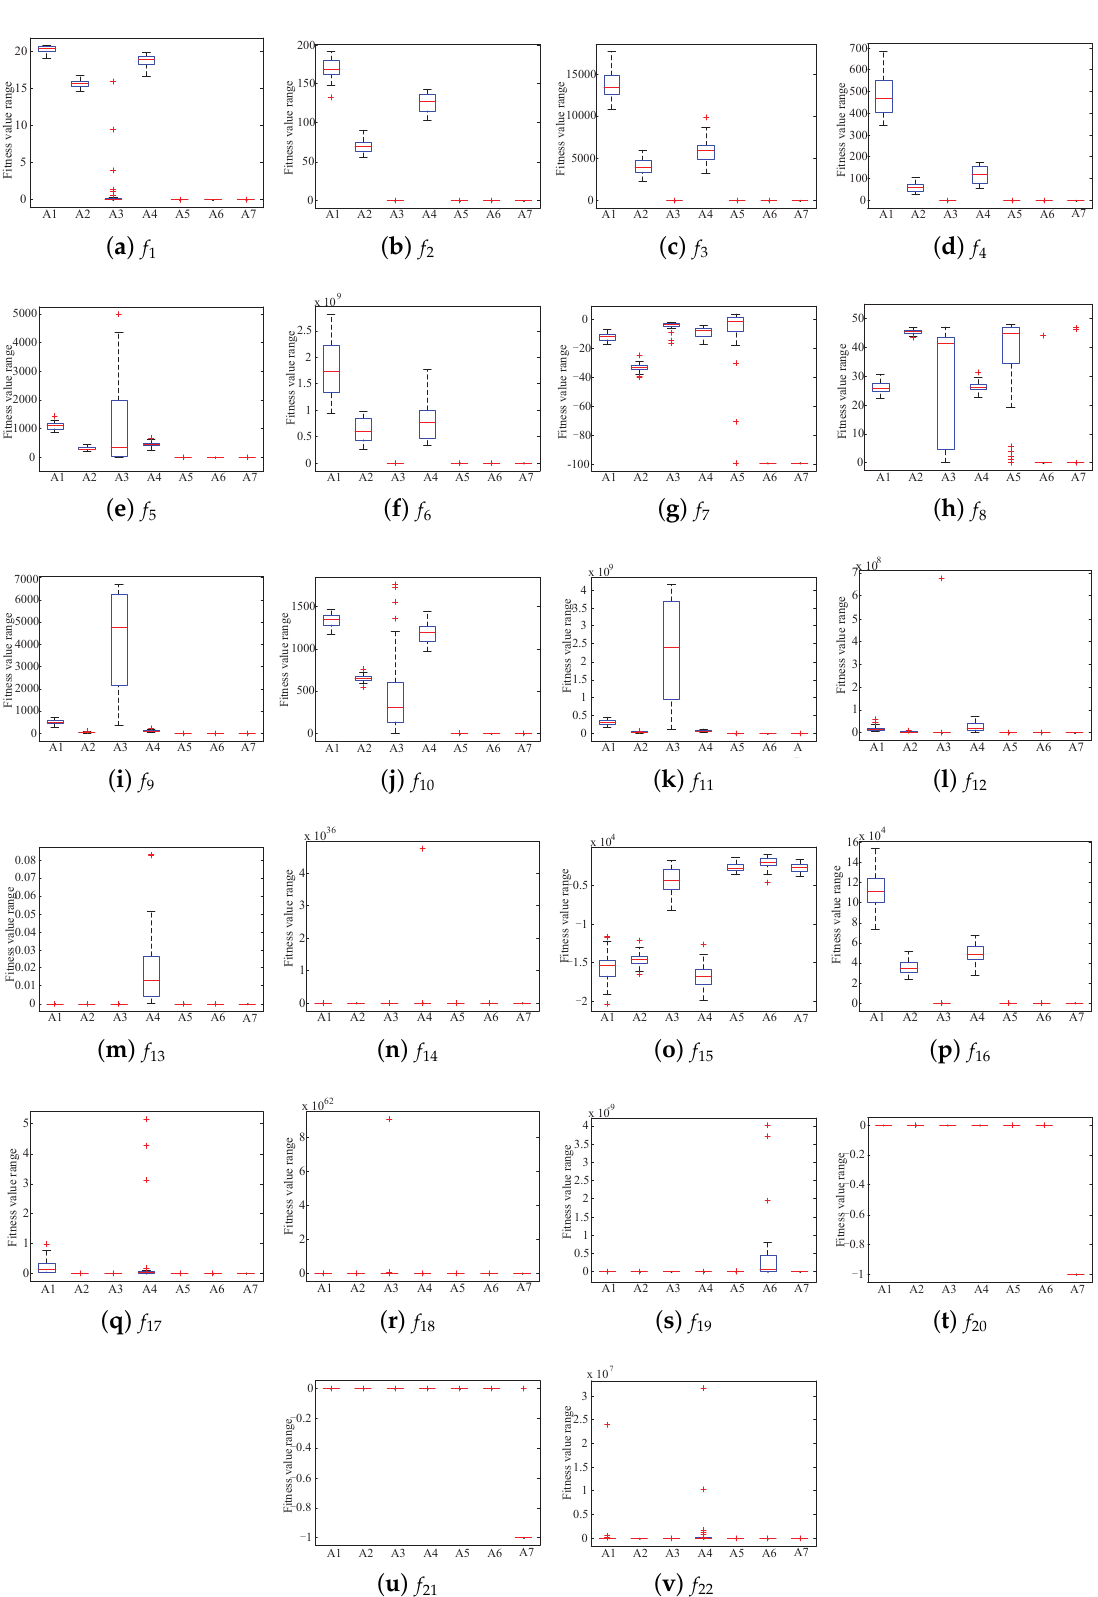
Figure 5. Box diagram of thirty results, each function with 100